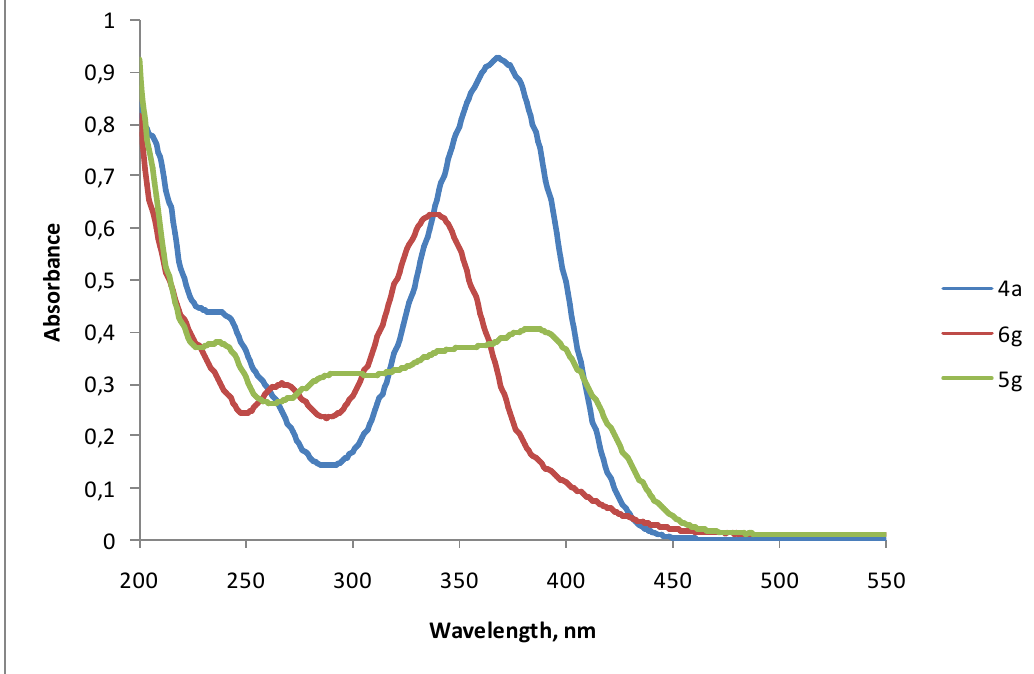
Figure 8. UV – Vis spectra of compounds 4a , 5g , 6g in MeCN (2 × 10 −5 M). Figure 8. UV–Vis spectra of compounds 4a , 5g , 6g in MeCN (2 × 10 − 5 Compounds 5g , n showed fluorescence upon excitation by light with the wavelength equal to the λ max in the visible region, as shown in Figures 9 and 10. Compound 5g has an emission maximum at 538 nm and a Stokes shift of 154 nm, whereas for compound 5n , these values are 571 nm and 168 nm, respectively. The large values of Stokes shifts (150 – 170 nm) almost completely eliminate the overlap between the absorption and emis- sion regions. In addition, the properties of these fluorescent molecules can be tuned by changing the substituent at the double bond.